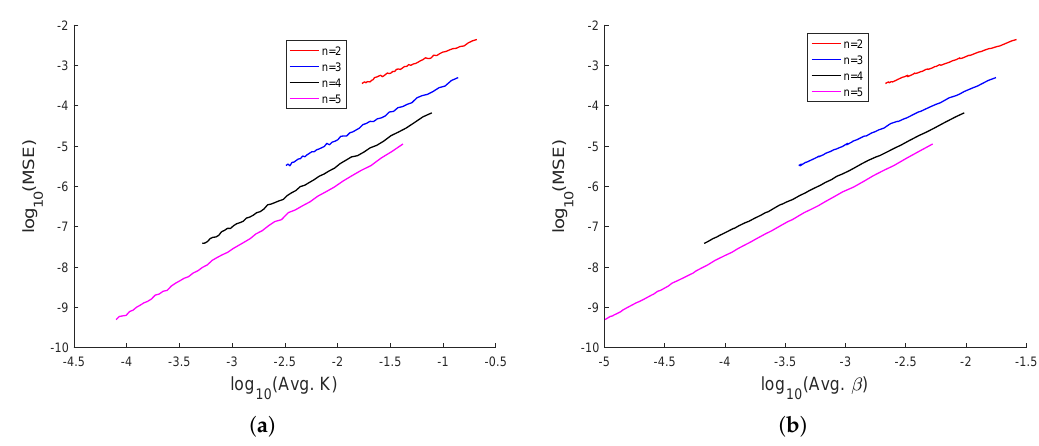
Figure 16. log (MSE) vs. logarithm of parameter-effects curvatures. ( a ) log 10 and ( b ) log (MSE) vs. log (Avg. β ) using 10 scalar measurements. 10 10